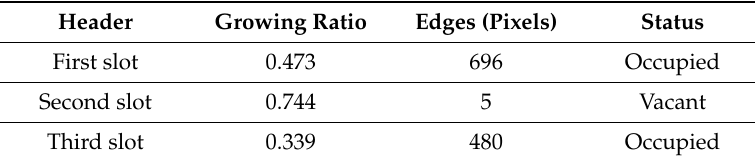
Figure 24. Experimental results in the parking lot under Xinsheng North Road Overpass. ( a ) Experimental setting; ( b ) Detection process; ( c ) Detection results. Table 3. Parking space features at Xinsheng North